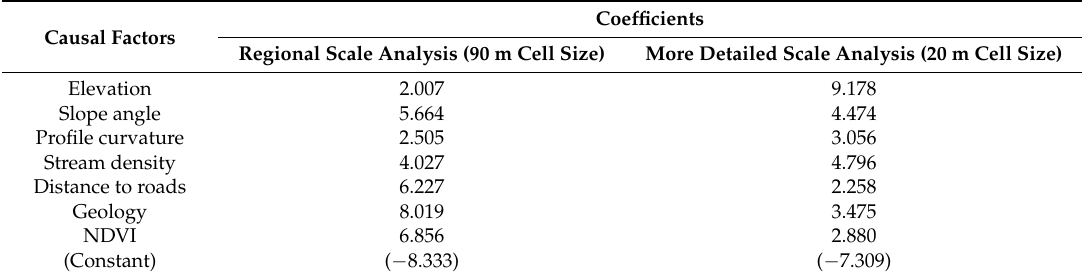
Table 3. Coefficients derived from logistic regression (LR) model for the causal factors.